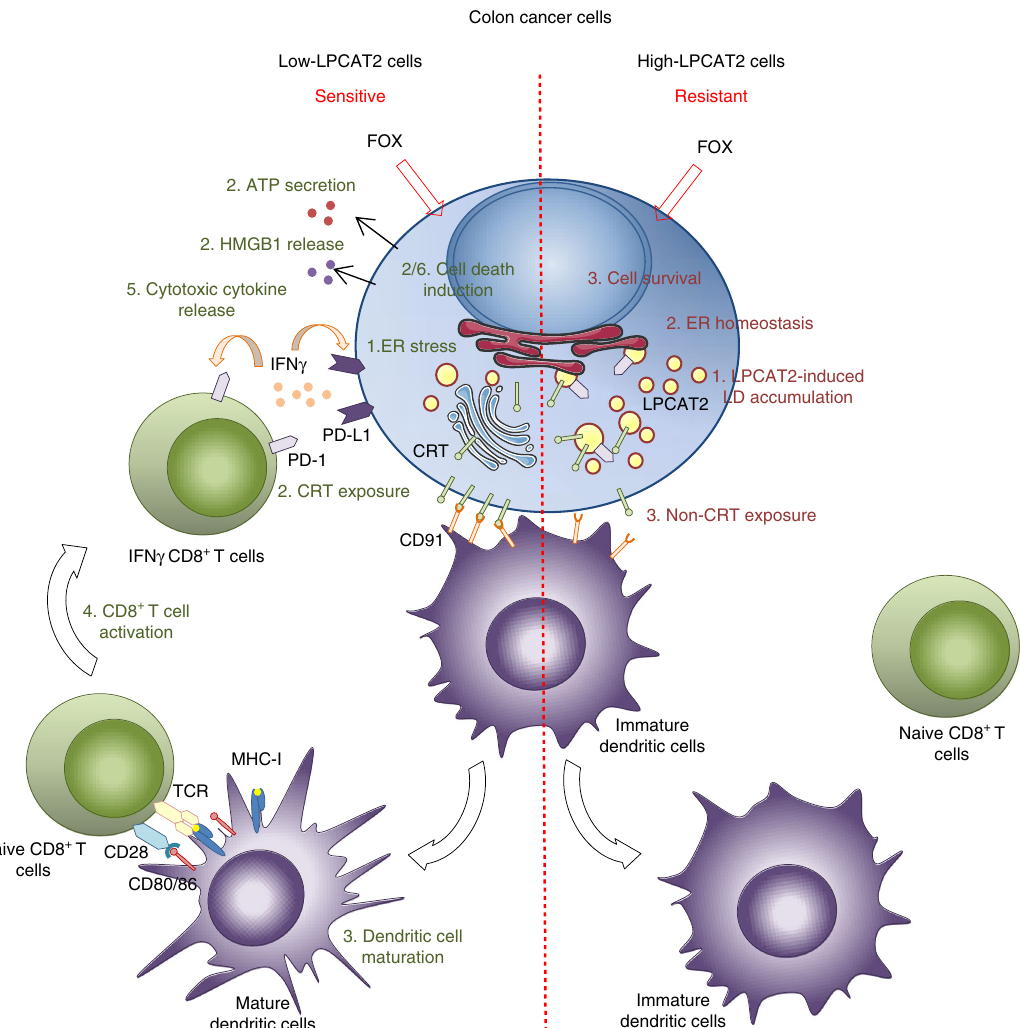
Fig. 10 Suggested model for chemotherapy-resistant CRC phenotype mediated by LPCAT2 overexpression. Contrary to sensitive cells, FOX treatment in high-LPCAT2 cells promotes LD accumulation leading to 1) ER homeostasis, 2) CRT sequestration into LD. The resulting failure in DC maturation leads to limited recruitment/activation of naïve CD8 + T cells via co-stimulatory factors CD80/86/MHC-I and CD28/TCR. Impaired ICD associated with reduced recruitment of IFN γ -secreting CD8 + T cells to tumour site could consequently avoid PD-L1 and PD-1 exposure on tumour and CD8 + T cells, respectively, and thus may lead to immunotherapy failure in addition to FOX resistance. HMGB1 High-mobility group box, IFN- γ interferon gamma, PD-1 programmed cell death-1, PD-L1 programmed cell death ligand-1, TCR T-cell receptor, MHC-I major histocompatibility